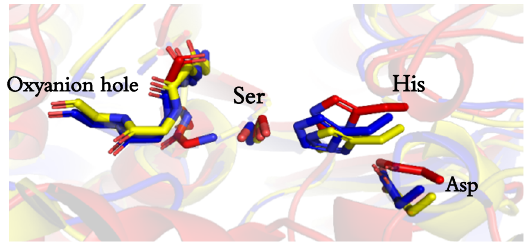
Figure 1. Active site details of the three esterases. Bacillus coagulants (BCE), represented in red, Halomonas elongata (HeE) in blue, and Bacillus subtilis (BS2m) represented in yellow. The active triad as well as the residues forming the oxyanion hole is presented.